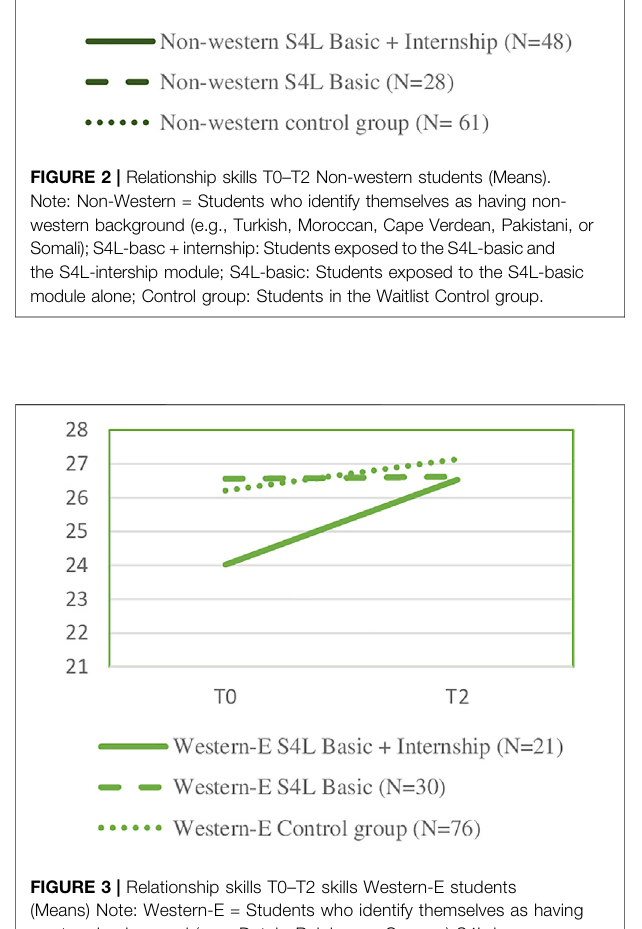
0.039) and relationship skills (d (cid:1) 0.33, p (cid:1) 0.009) (for estimates of